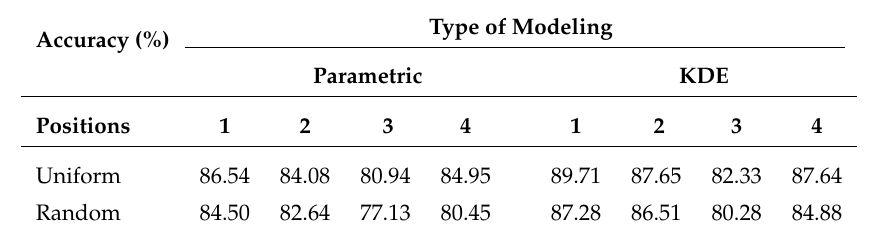
Table 3. Influence of the type of modeling and distribution of reference positions on the overall accuracy (%). Accuracy (%)